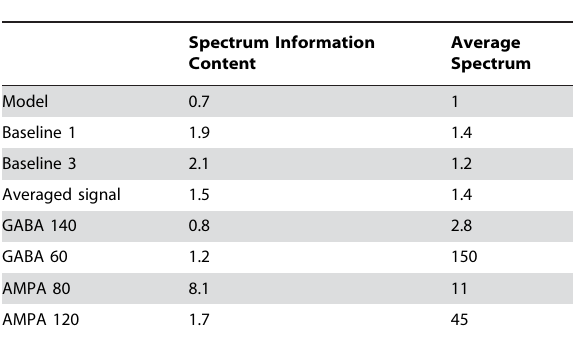
Table 1. Goodness-of-fit with experimental data of model LFP in presence of signal and synaptic modulations, measured with x 2 (see r